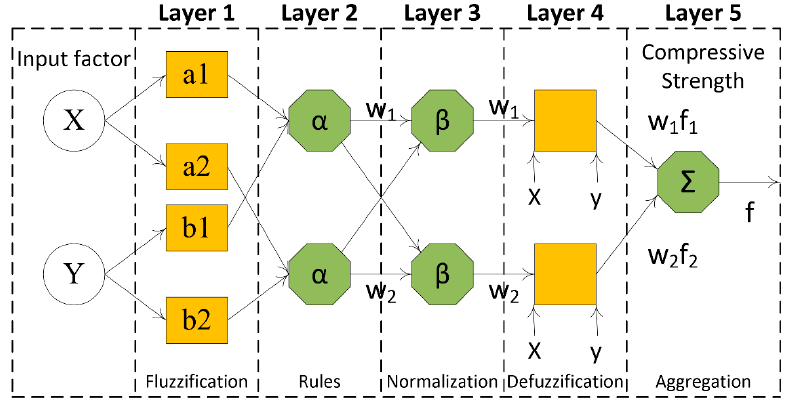
Figure 1. The structure of the adaptive neuro fuzzy inference system (ANFIS) algorithm.